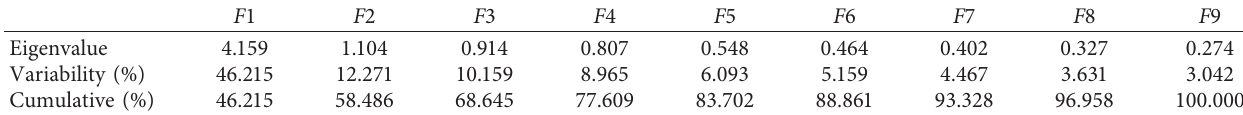
Table 5: Eigenvalues proportion of explained variability of the score difference.